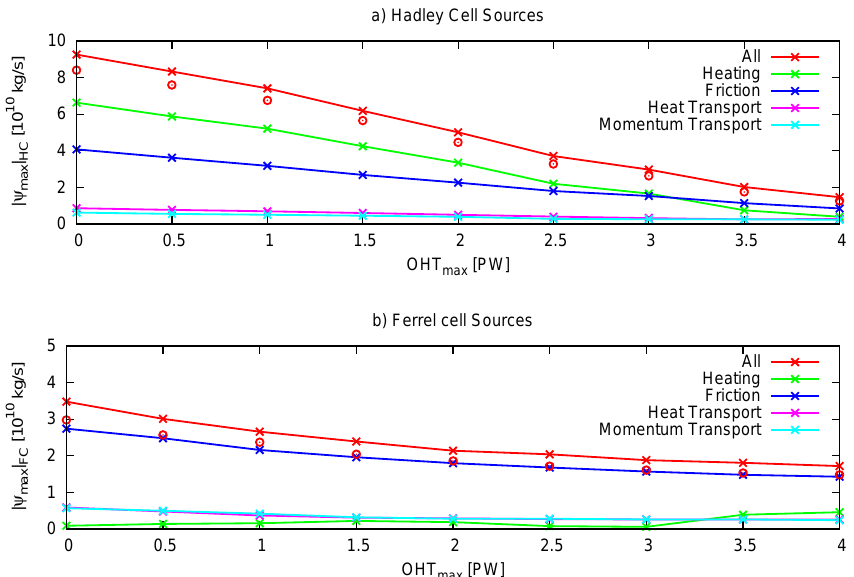
Figure 15. Sources (in 10 10 kgs − 1 ) of the Hadley (upper panel) and the Ferrel (lower panel) cell according to the Kuo–Eliassen equation. Circles indicate the actual strength of the respective cell.